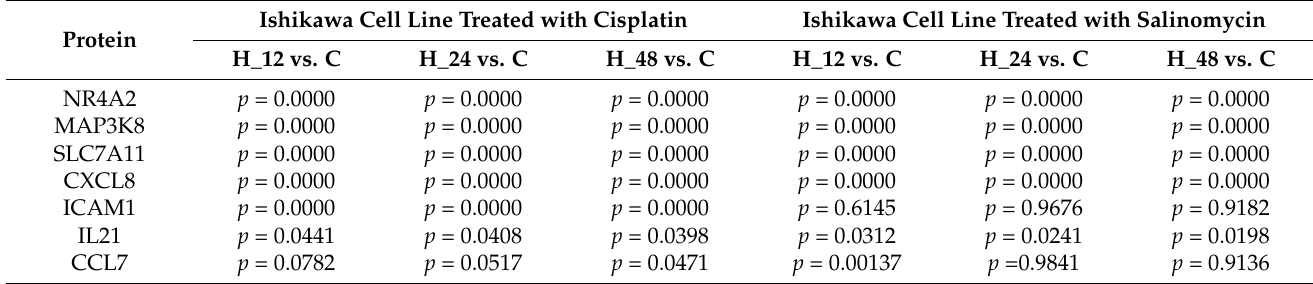
Table 5. Results of the one-way ANOVA and post hoc Tukey’s test for ELISA